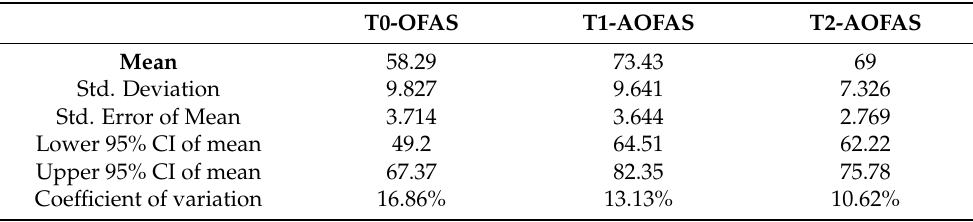
Figure 4. AOFAS values before treatment (T0), 21 days after treatment (T1) and at 3-months follow- up (T2). Table 3. AOFAS results before treatment (T0), 21 days after treatment (T1) and at 3-months follow- up